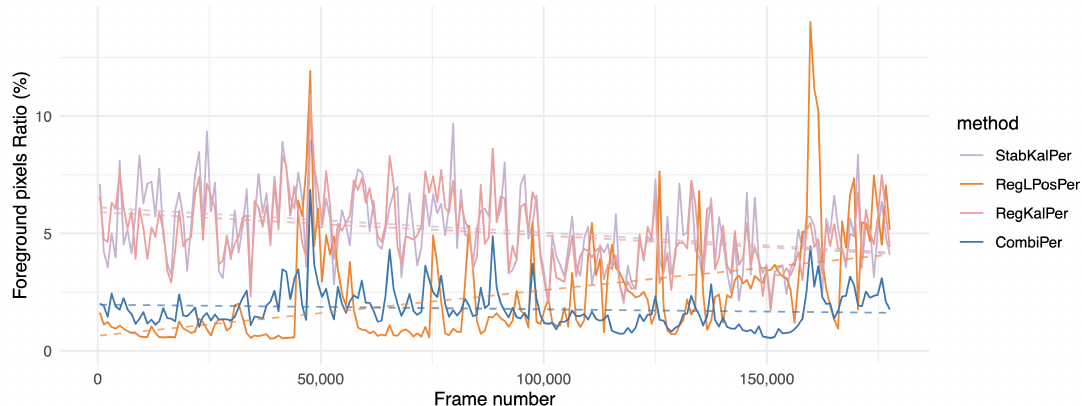
Figure 9. Evolution of the foreground pixel ratio ( fgr ) indicator over time on the two hours long L2 sequence (the lower, the better). Values were aggregated by averaging on intervals of approximately 1000 frames. For more clarity, we kept only the methods using homographies. The dashed line corresponds to a linear regression over the whole